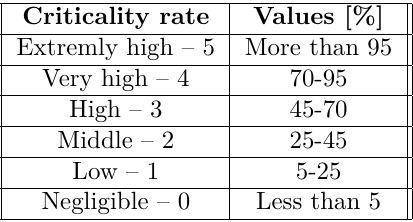
Table 2. Value scale according to